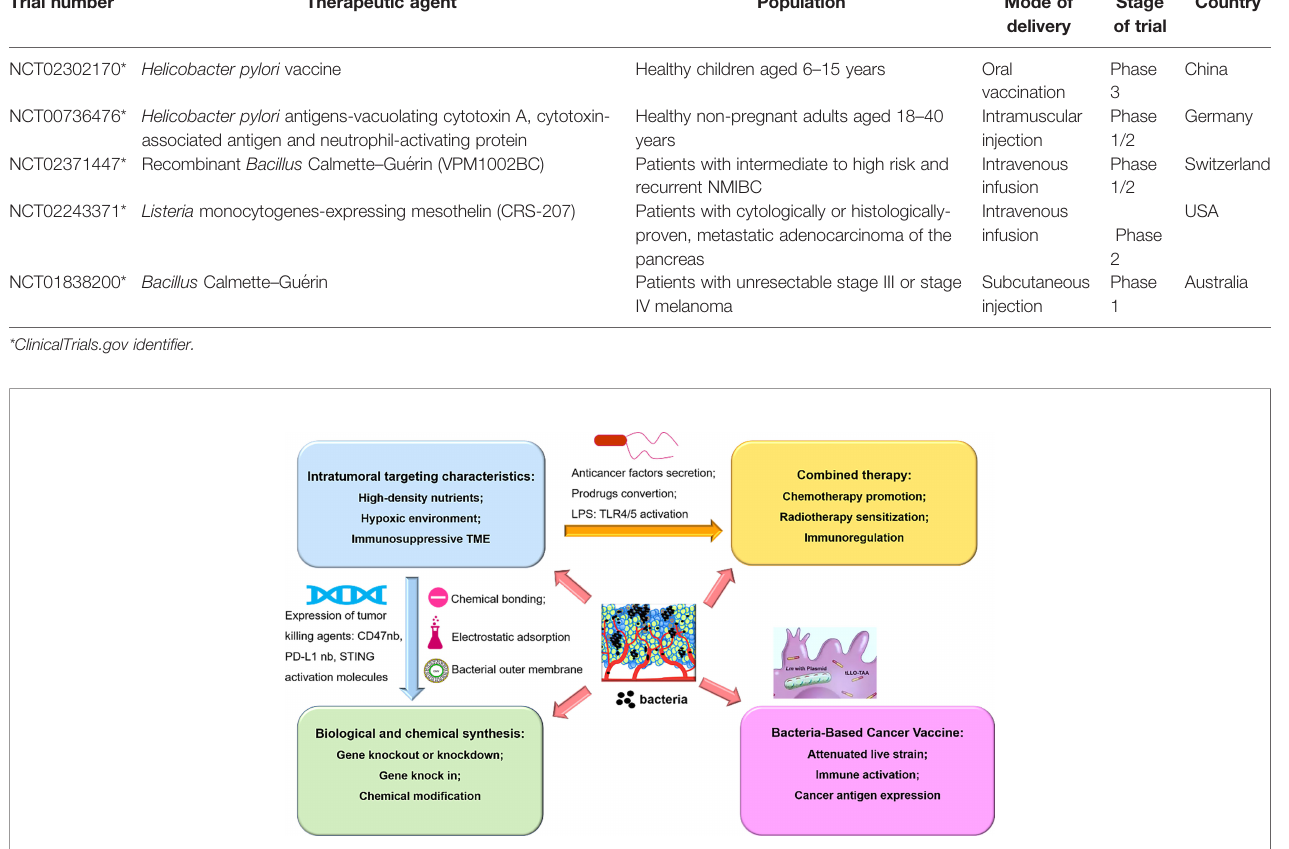
FIGURE 2 | An overview of bacteria-based synergistic therapy, namely, the mechanism of tumor targeting properties, combined therapy with chemoradiotherapy or immunotherapy, chemical modi fi cation or biological engineering, and bacteria-mediated delivery of cancer